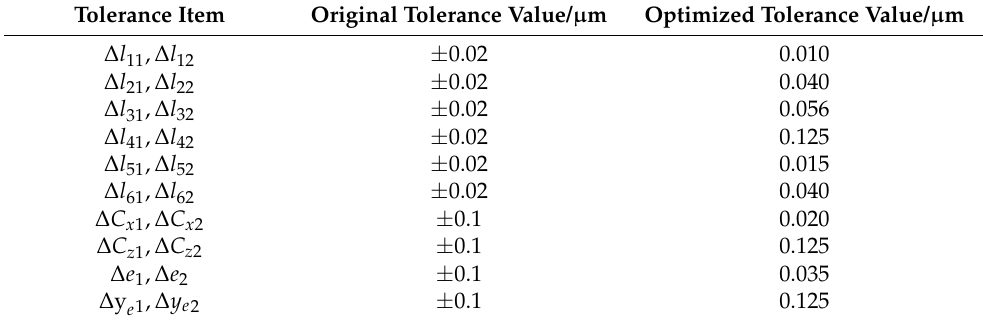
Table 4. Results of the tolerance optimization.